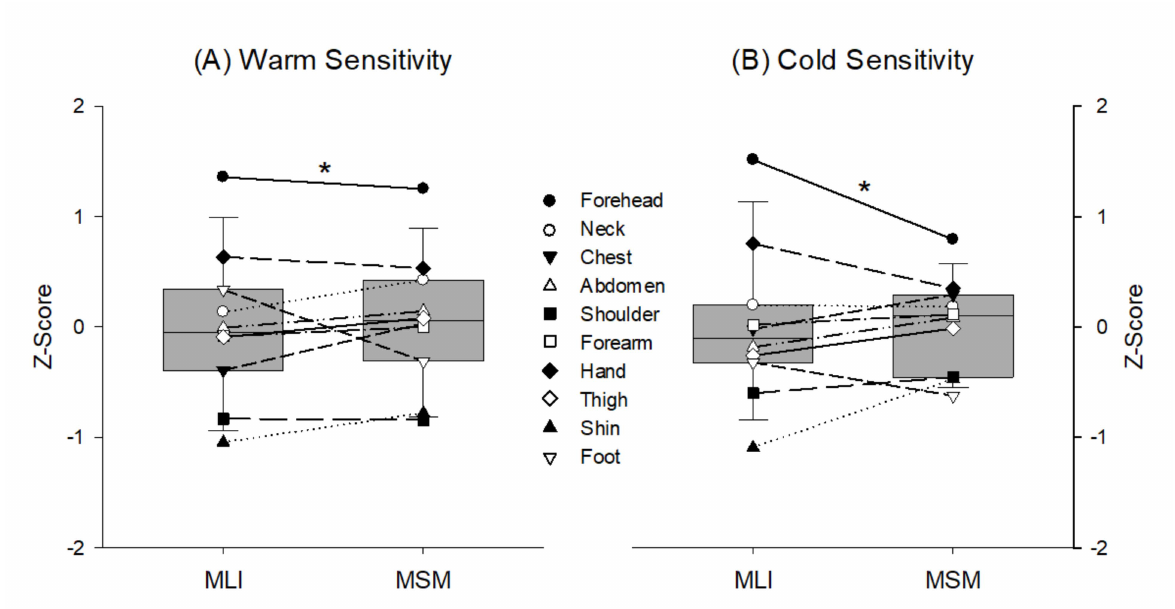
Figure 2. Standard score (Z-score) of warm and cold sensitivity between the method of limit and method of level across ten body regions. *: The forehead was the most sensitive to both warm and cold stimuli regardless of the test method ( p <